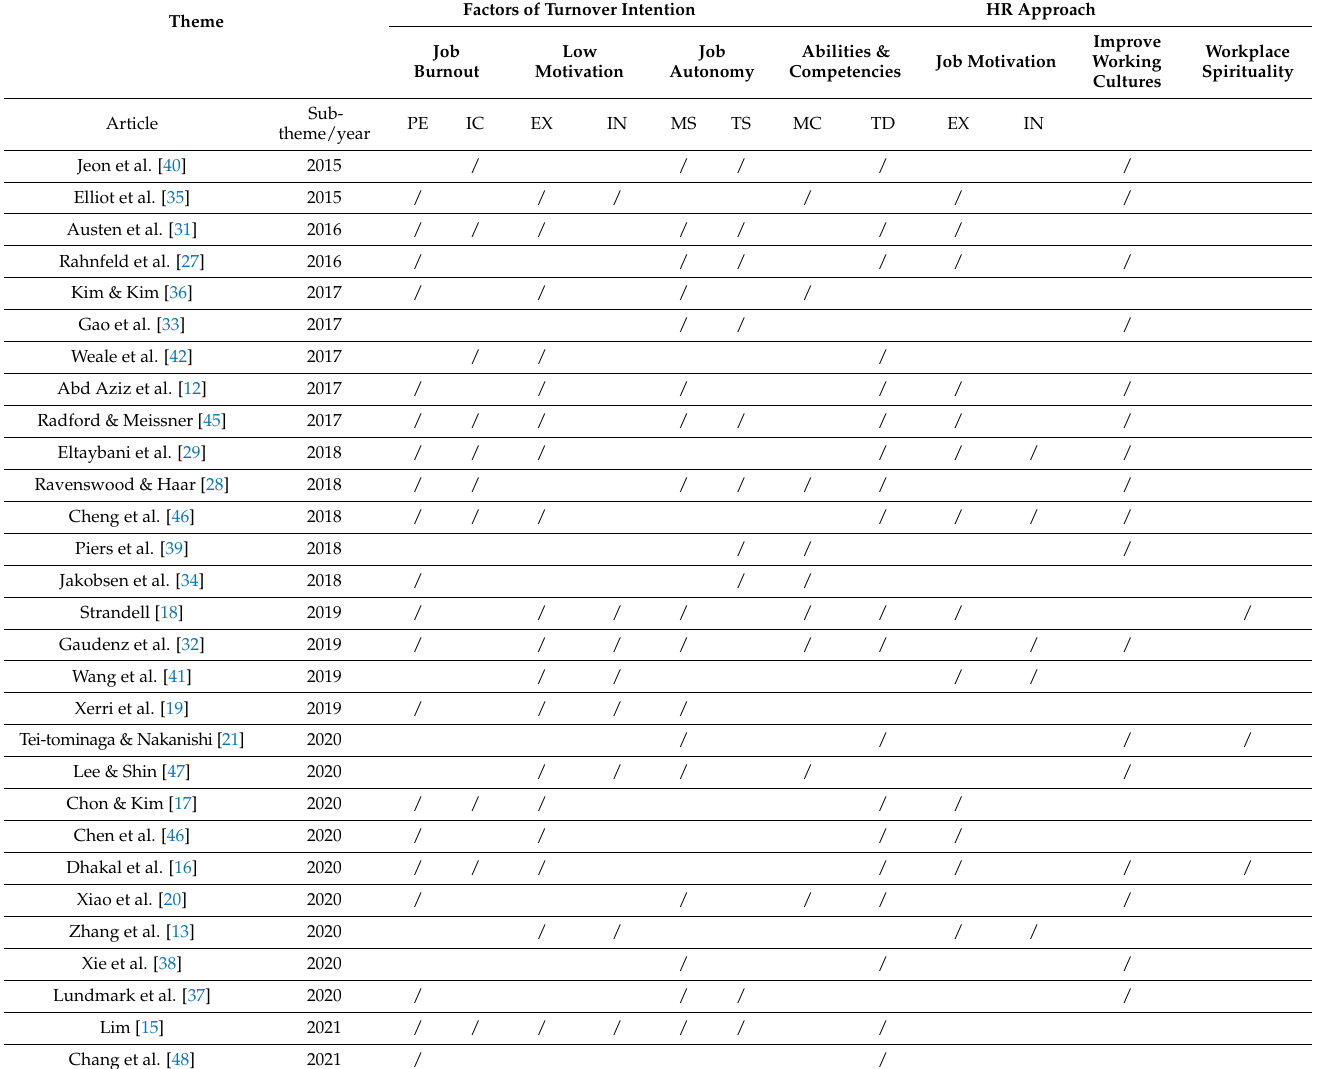
Table 3. Themes and sub-themes derived from the thematic